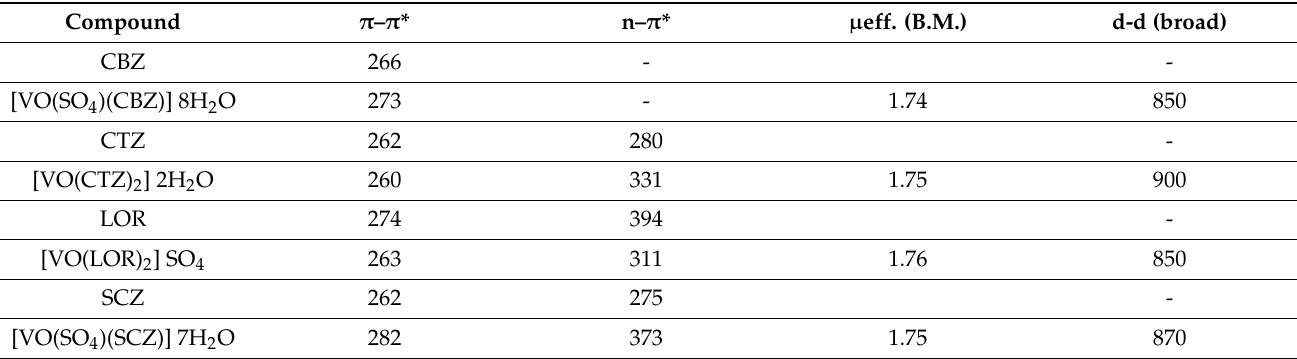
Figure 3. Electronic absorption spectrum of free CTZ ligand and its metal complex (inset shows the d-d transition the metal complex). Table 3. Electronic spectra data of ligand and their oxidovanadium(IV) complexes and their magnetic moment values.